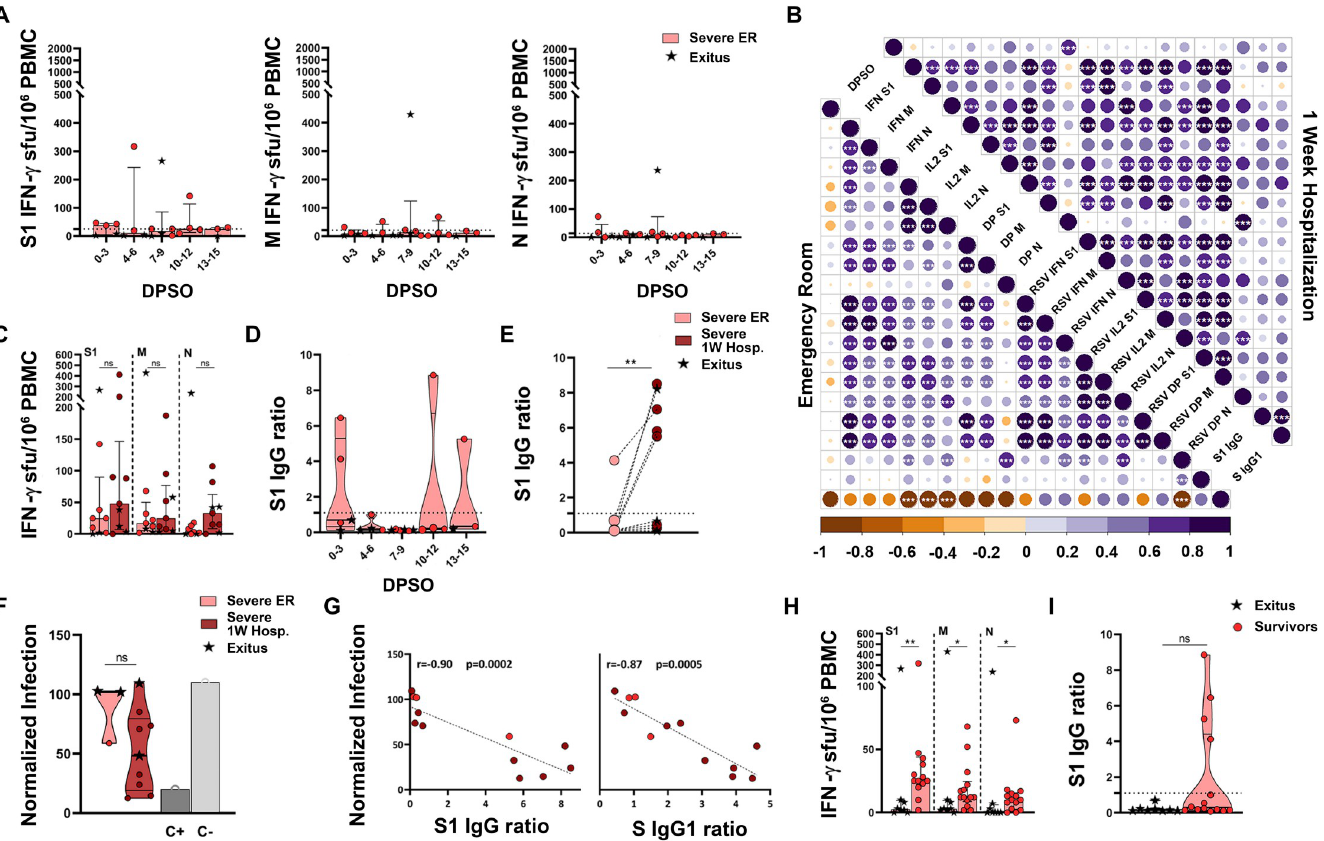
Fig 4. Cellular and humoral immune responses in severe natural infection, during acute phase, measured at emergency room (ER) and a week after hospitalization (1W Hosp.). ( A ) FluoroSpot IFN- γ responses against SARS-CoV-2 S1, M and N proteins according to the days post-symptom onset (DPSO). Dashed lines represent the positivity cut-off established by using a non-infected control group: > 25 sfu/10 6 PBMC for S1, > 21sfu/10 6 PBMC for M and > 14 sfu/10 6 PBMC for N. ( B ) Correlation matrices of cellular and humoral immune variables analyzed. Only significant correlations (p < 0.05) are represented with asterisks. ( C ) FluoroSpot IFN- γ responses against SARS-CoV-2 S1, M and N proteins at ER and a week after hospitalization. ( D-E ) Results of SARS-CoV-2 S1 IgG ELISA according to DPSO. ( F ) Neutralizing capacity tested with S protein-pseudotyped virus represented as percentage of normalized infection neutralized. ( G ) Correlation between neutralizing capacity and the semi-quantitative results of SARS-CoV-2 IgG ELISA (left) and anti-Spike IgG1 assessed by flow cytometry (right). ( H-I ) Comparison of S1, M and N T-cell (H) and anti-S1 IgG (I) responses between survivor and non-survivor patients (black stars). Linear regressions were performed using Spearman’s rank test. Horizontal bars and whiskers represent median values and interquartile ranges, respectively. The significance between groups was determined using Mann Whitney, Wilcoxon signed rank or Kruskal-Wallis tests, � p < 0.05, �� p < 0.01, ��� p < 0.001, ���� p < 0.0001. (See Fig 2 footnote for more detailed information).